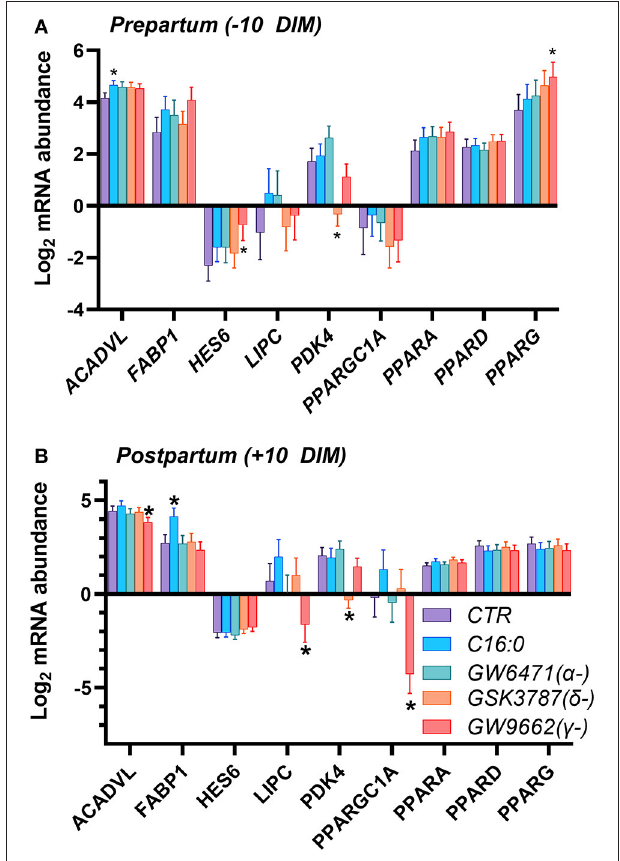
which were treated with isotype-specific agonists for PPAR α (WY-14643), PPAR δ (GW-501516) and PPAR γ (rosiglitazone).